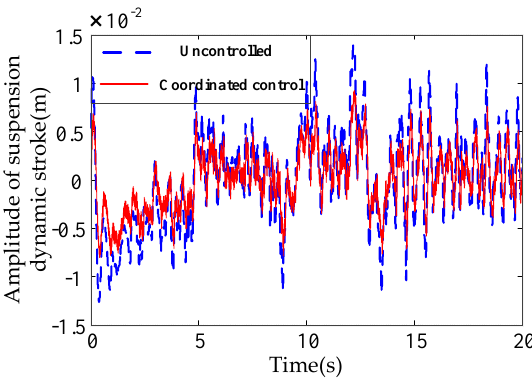
Figure 19. Response of dynamic stroke for front left suspension.